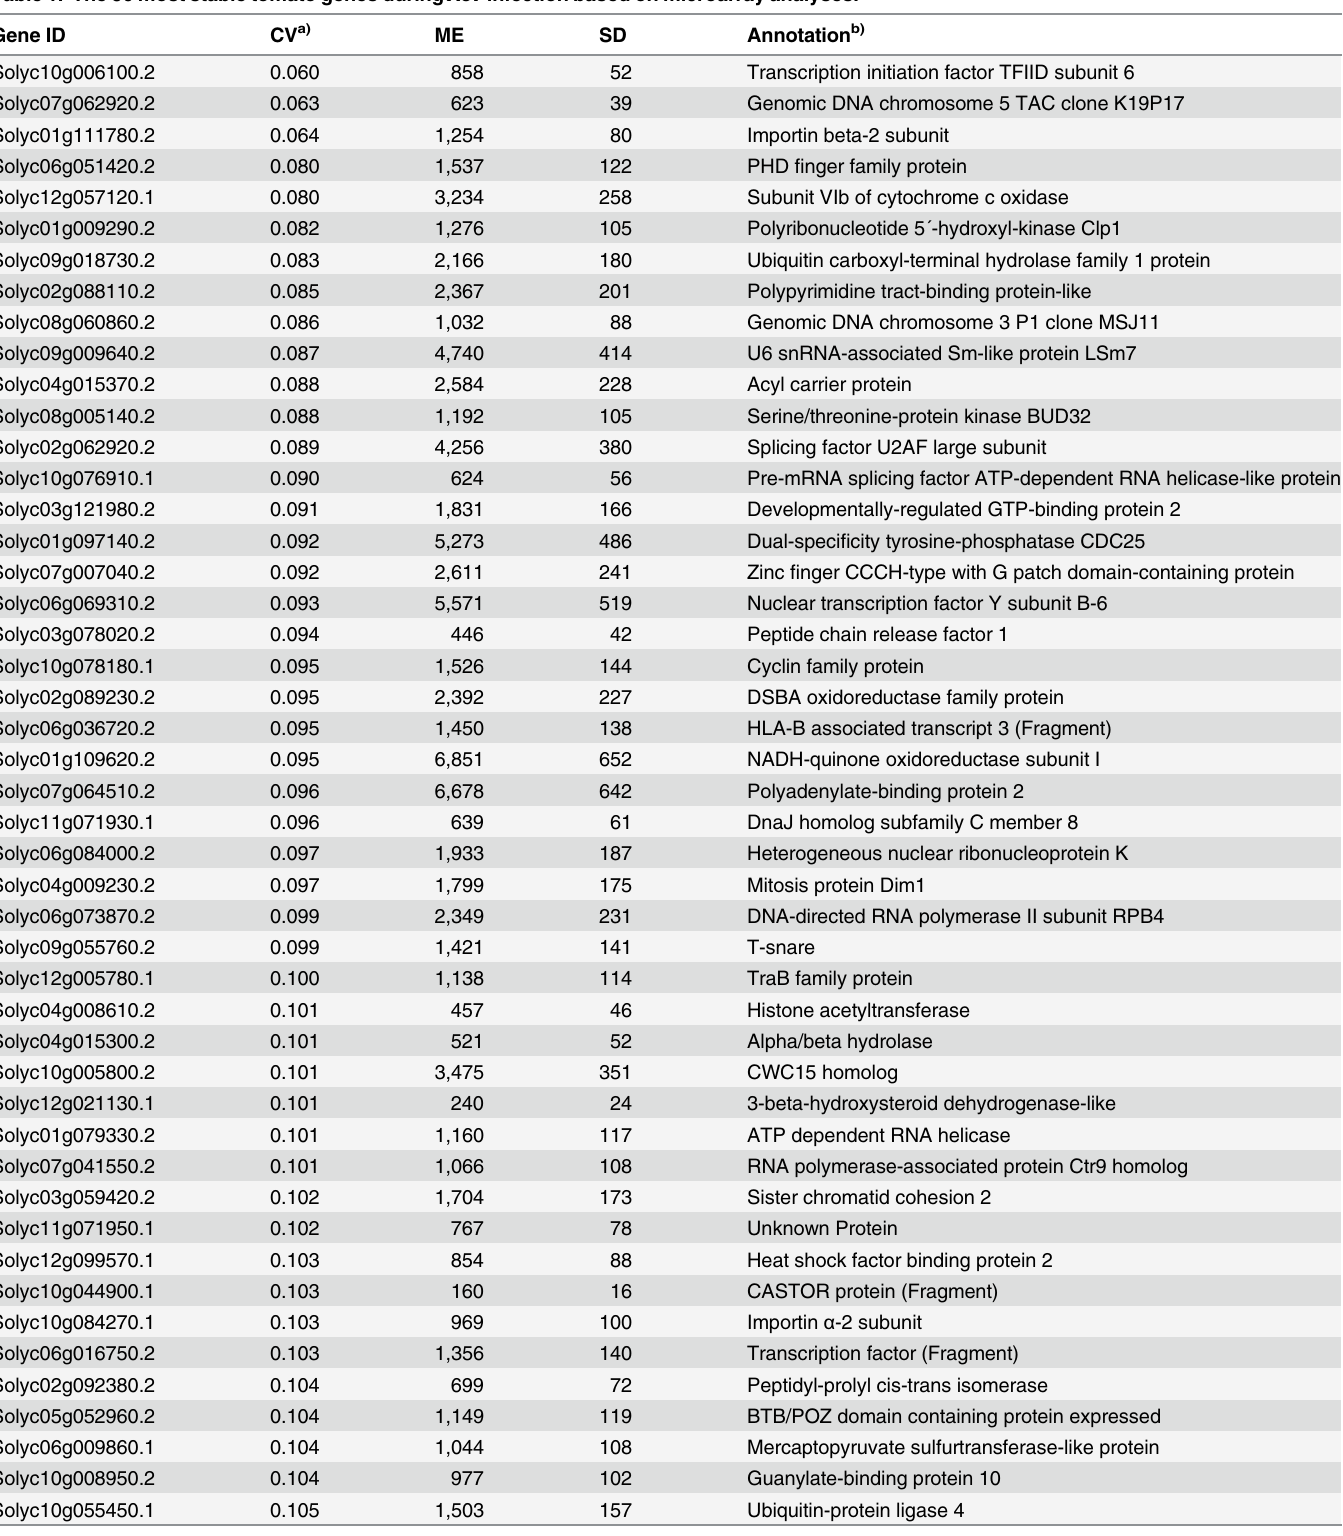
Table 1. The 50 most stable tomato genes during Xcv infection based on microarray